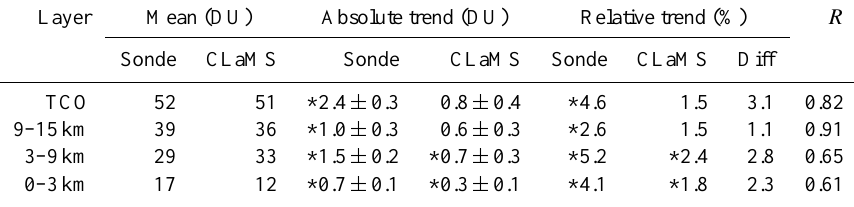
Table 1. Trends of monthly mean partial column ozone from observation (Sonde) and simulation (CLaMS) during 2002–2010 a . Layer Mean (DU) Absolute trend (DU) Relative trend (%) R Sonde CLaMS Sonde CLaMS